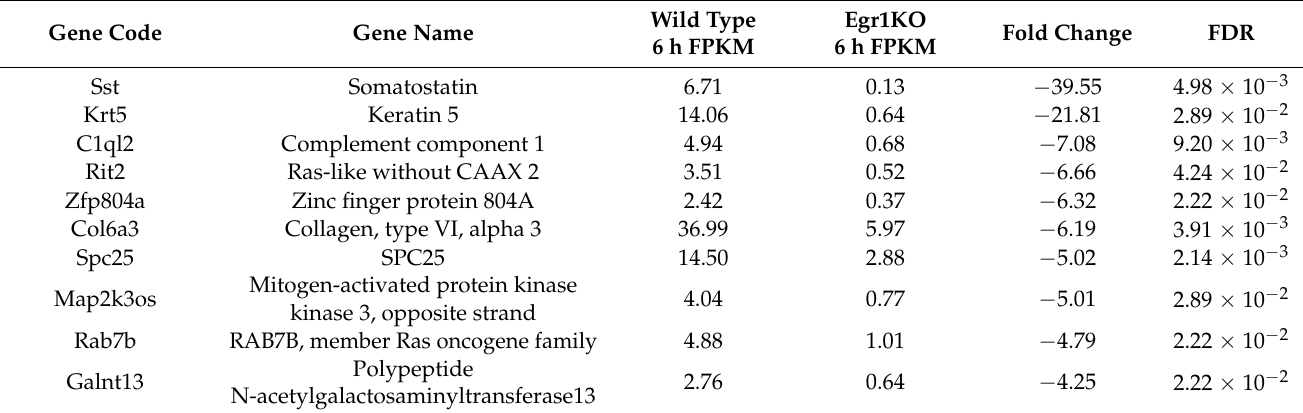
Table 5. Topmost downregulated DEGs seen in Egr1KO LECs at 6 h